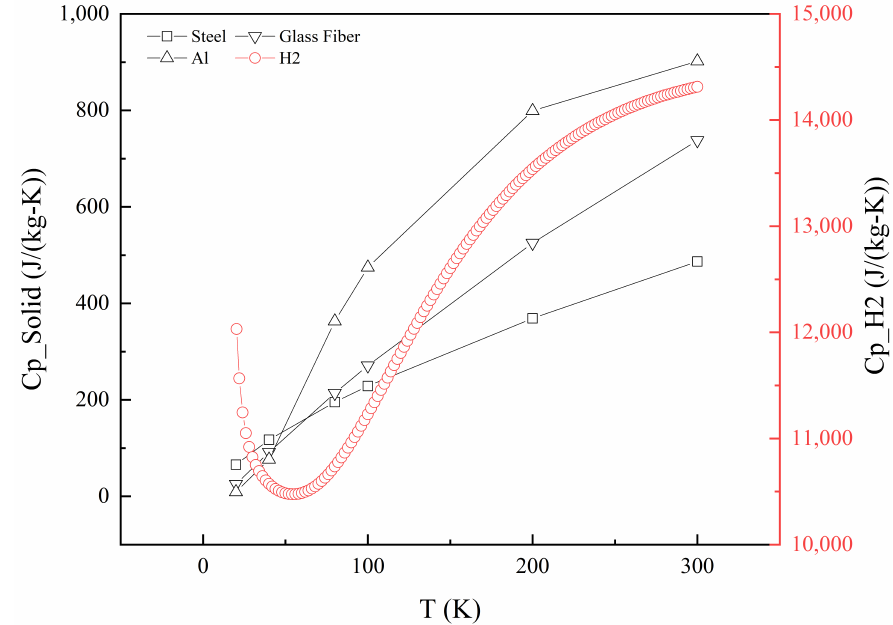
Figure 3. Specific heat of liquid and solid materials in a liquid hydrogen tank.